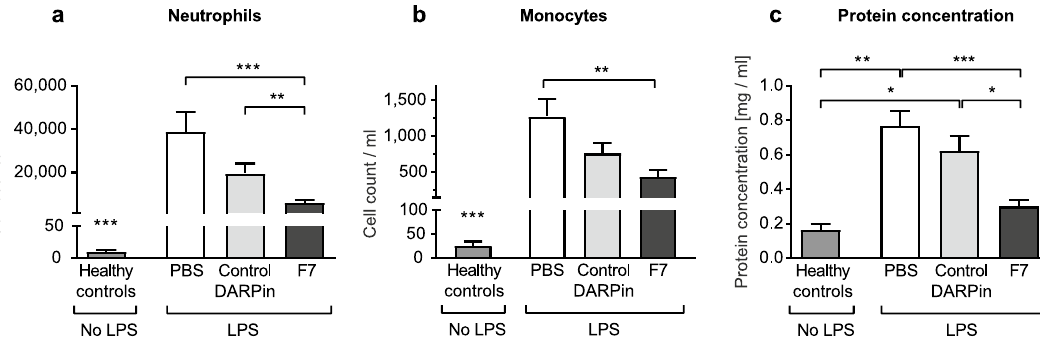
Figure 4. F7 reduces monocyte and neutrophil count and protein content in the bronchoalveolar lavage fluid (BALF) during the acute phase. Neutrophils and monocytes were analyzed by flow cytometry as described in the “Methods” section. Protein content in the BALF was determined using a BCA assay. Absolute cell counts were determined using Trucount beads following the manufacturer’s instructions. ( a ) Animals treated with DARPin F7 had significantly lower neutrophil counts in the BALF than the PBS or control DARPin treated groups. Compared to healthy control animals, neutrophil counts were elevated in all treatment groups. ( b ) Monocyte counts in the BALF were also significantly reduced in the F7 treated group compared to the PBS treated group. Again, monocyte counts were elevated in all treatment groups compared to healthy controls. ( c ) The protein concentration in the BALF was significantly higher in mice receiving PBS or the control DARPin compared to mice treated with F7. Data are presented as mean ± SEM. n = 5–19, * p < 0.05, ** p < 0.01, *** p < 0.001. Treatment groups were compared by an unpaired t-test.